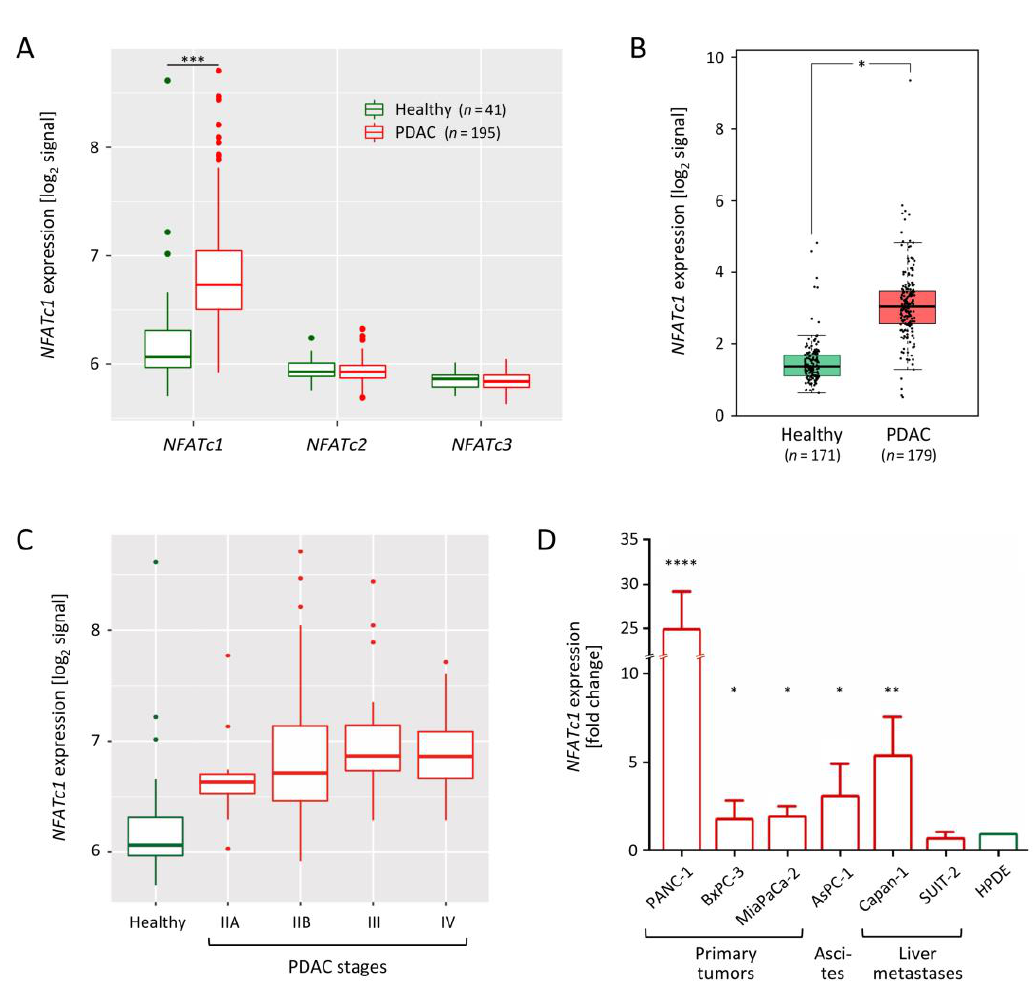
Figure 2. Expression of NFATc1 in pancreatic cancer cell lines and tissues. ( A ) mRNA levels of NFAT TF genes in PDAC and healthy tissues [18]. ( B ) Same analysis for NFATc1 on the basis of data from the TCGA and GTEx data repositories. ( C ) Variation in NFATc1 transcript levels across PDAC stages. ( D ) Quantification of NFATc1 mRNA levels in tumor cell lines in comparison to the non-cancer cell line HPDE-E6E7 (HPDE). * = p ≤ 0.05; ** = p ≤ 0.01; *** = p ≤ 0.001; **** = p ≤ 0.0001.